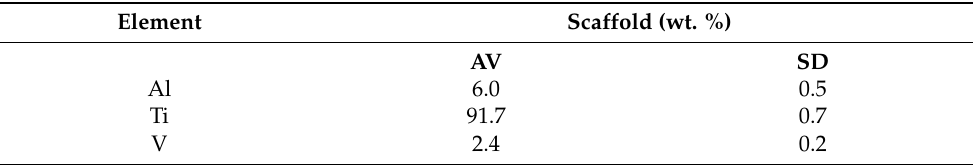
Table 6. Chemical composition of scaffold obtained by EDS analysis. AV—average value, SD— standard deviation.